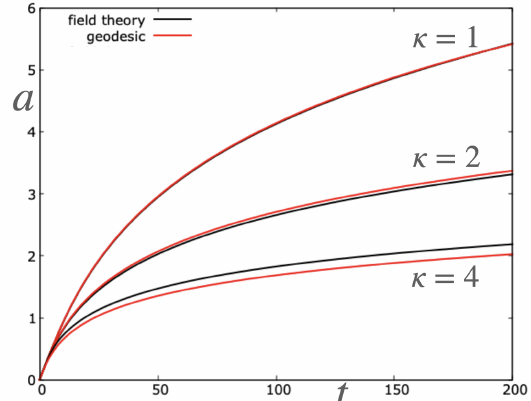
Figure 1 . The black curves give the position a of the kink obtained from a field theory simulation with an initial condition given by a 0 = 0 and v = 0 . 1 . The red curves are the corresponding geodesic approximation, using the boundary metric in the case κ = 4